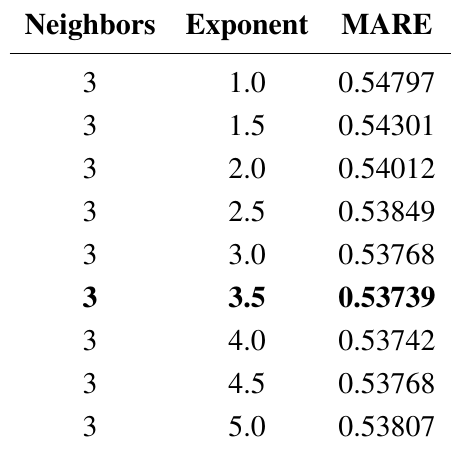
Table 2. MARE LOOCV results for nine IDW methods with three nearest neighbors using the original IDW-based